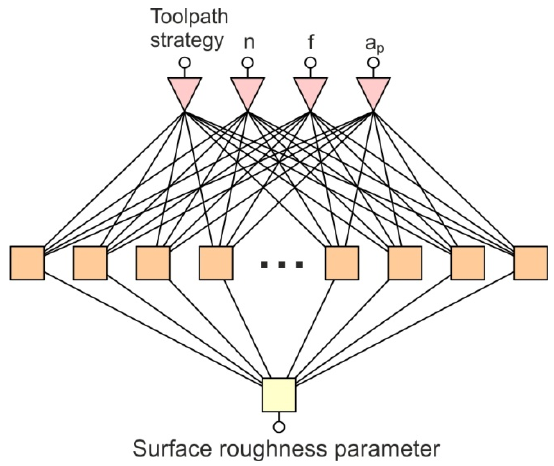
Figure 5. Architecture of a multilayer perceptron: n—spindle speed, f—feed rate, a p —incremental step size.